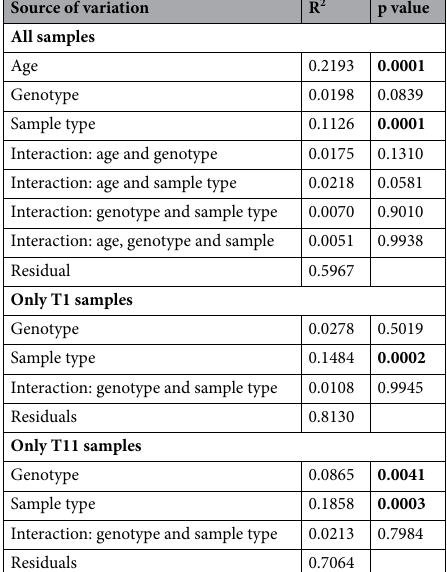
Source of variation R 2 p